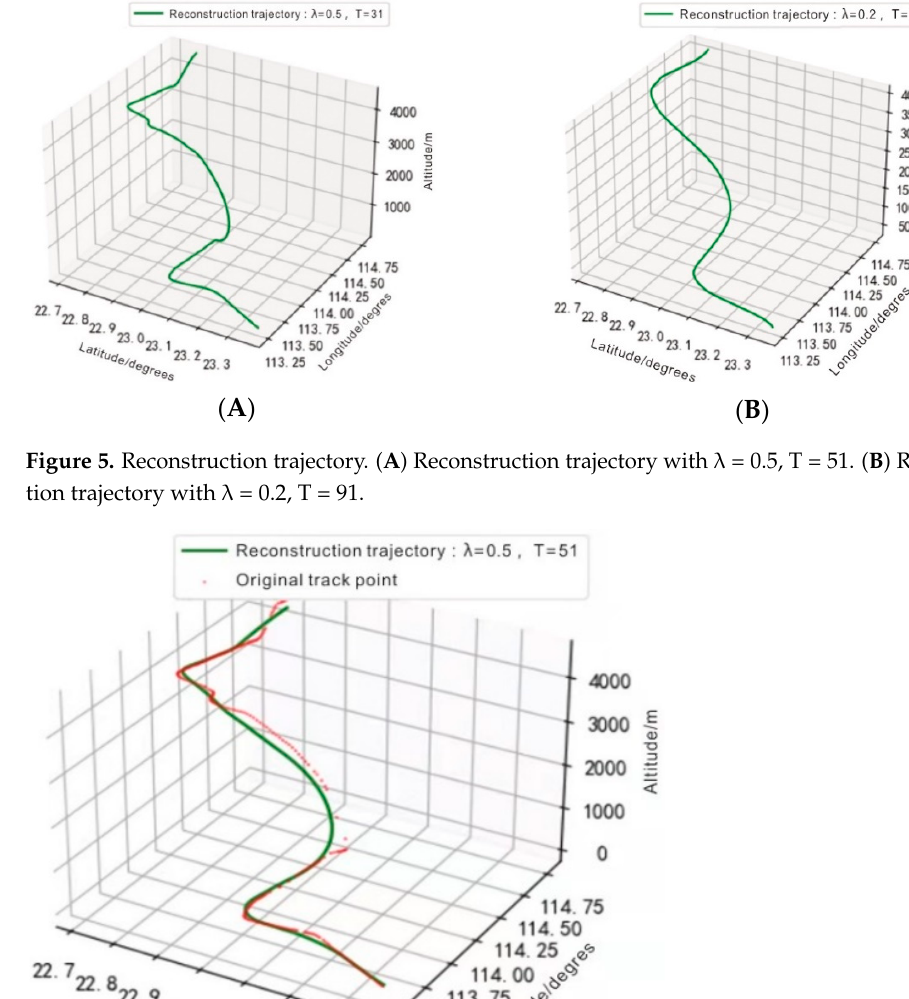
Figure 6. Trajectory comparison.